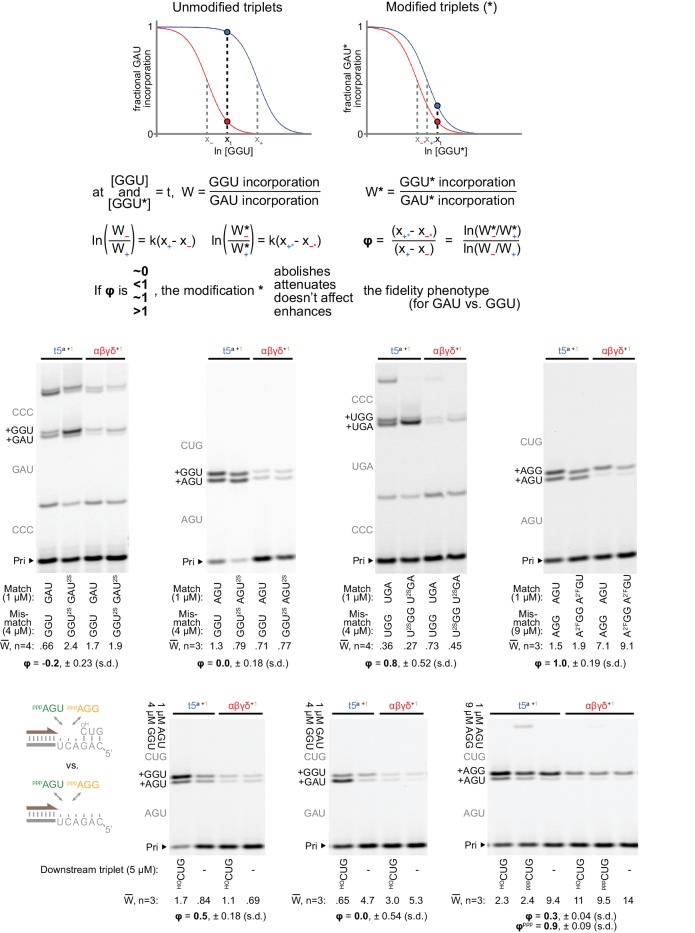
Determination of residual fidelity phenotype when using minor groove-modified substrates.Top: framework for estimation of residual fidelity phenotype (ϕ). Shown are model logistic curves for incorporation of a triplet, for example GAU (at a fixed concentration, opposite 3’-AUC-5’), versus increasing concentrations of a mismatching triplet, for example GGU. A ribozyme ‘+’ with a fidelity function (e.g. t5a, blue curve) will incorporate equal amounts of the matched and mismatched triplets at a different concentration of the mismatched triplet compared to a ribozyme ‘−’ without a fidelity function (e.g. αβγδ, red curve). x+ and x− represent the lns of these concentrations for + and −; their separation (x+ - x−) is a proxy for the strength of the ‘+’ fidelity phenotype. We measured the relative incorporation (W) of triplet pairs by the two triplet polymerases at test concentrations (t) of mismatched triplet, chosen to maximise the difference in the ribozymes’ resulting fractional incorporations (marked by a blue dot vs. a red dot on respective curves). If a triplet modification (*, right) interferes with mismatch discrimination by ‘+’, it would shift the ‘+’ relative incorporation curve (blue) towards that of ‘−’ (red), reducing the difference in fractional incorporation. Assuming curve steepness (k) remains constant, the residual phenotype (ϕ) for that modification is described by the new separation (x+* - x−*) as a proportion of the original separation (x+ - x−); numerical values and calculations from the measurements described below are supplied in Figure 8—source data 2. Middle: measurements of ratios of incorporation vs. misincorporation (W) for unmodified and modified triplet pairs (at the indicated test concentrations) by the t5a +1 triplet polymerase compared to the ε fidelity domain-truncated αβγδ+1 (at 0.5 μM each). The expected triplet additions are in grey along the left of each gel; the average W from n independent experiments, calculated via densitometry of products containing slower-migrating G misincorporations, is shown below each lane along with the average ϕ. Primers (P), templates (T) and additional triplets were at 0.5/0.5/5 μM, incubated for three days in −7˚C ice. Left: presence of a 2-thiouracil (2SU) at the third position of the triplet abolishes the fidelity domain’s ability to discriminate against a second position wobble pair (P: A10, T: CCCMisGAU, +5 μM pppCCC). Centre-left: the same third position modification (2SU) also abolished the fidelity domain’s preference for G misincorporation at the first position (P: Fγ7, T: TγAGU, +5 μM HOCUG). Centre-right: in contrast, a 2SU at the first position of the triplet exerted no clear influence upon third position wobble discrimination (P: A10, T: CCCMisUGA, +5 μM pppCCC). Right: replacement of a 2’ hydroxyl group with a 2’ fluoro (2’F) at the first triplet position likewise had no effect upon third position mismatch discrimination (P: Fγ7, T: TγAGU, +5 μM HOCUG). Below: Measurement of fidelity phenotype in the presence or absence of a downstream triplet. Residual phenotypes indicate attenuation or abolishment of third position (left panel, P Fγ7, T TγAGU), second position (middle panel, P Fγ7, T TγGAU), and third position (right panel, P Fγ7, T TγAGU) fidelity effects from downstream triplet absence. No effects are seen (upon third position discrimination) from the presence or absence of a 5’ triphosphate on the downstream triplet (ϕppp). In the absence of a triplet bound downstream on the template, the fidelity phenotype is severely compromised, suggesting this adjacent triplet:template duplex plays a critical role in positioning the fidelity domain relative to the incoming triplet.